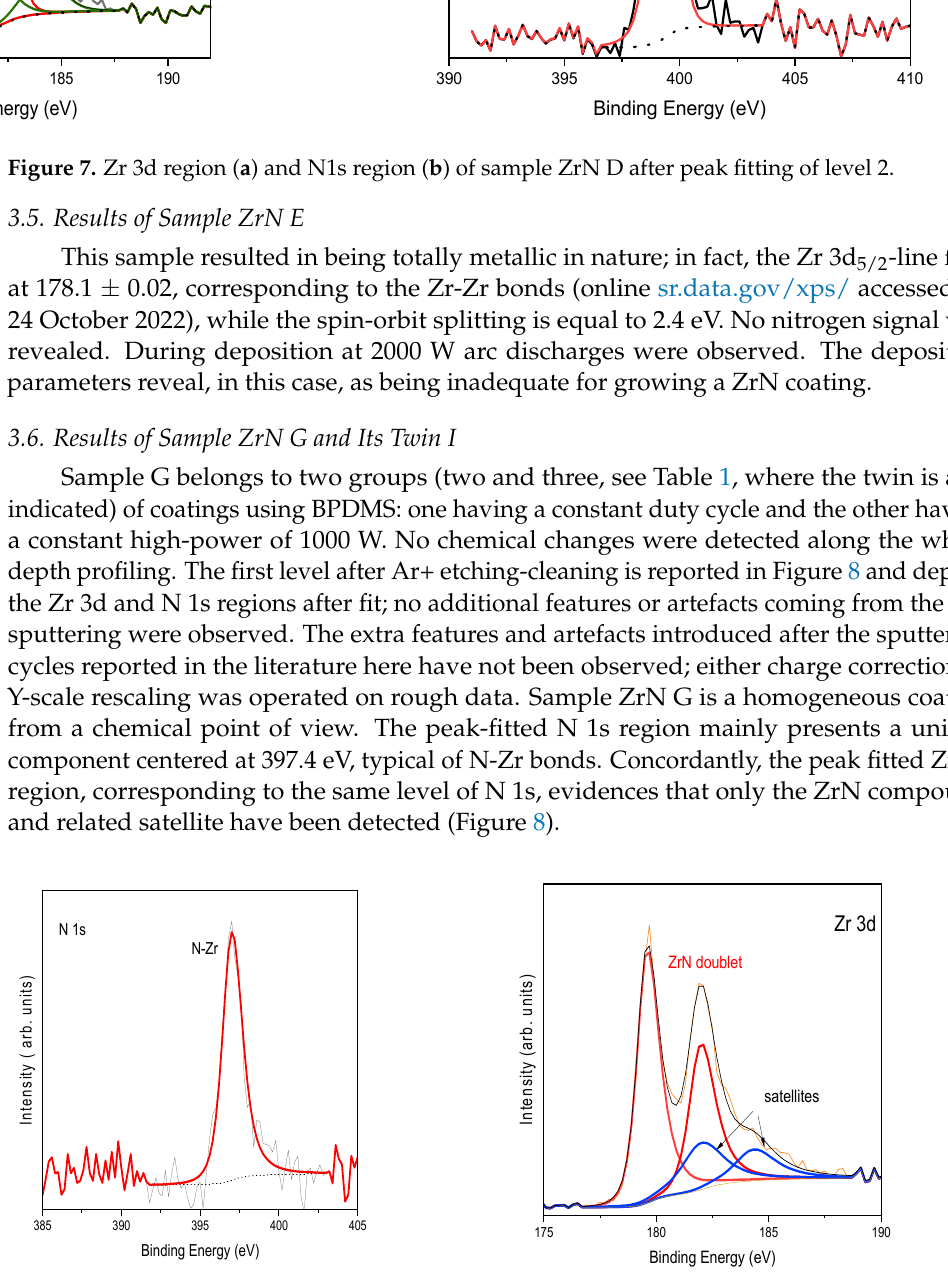
Figure 7. Zr 3d region figure 7 a ) and N1s region figure 7 b ) of sample ZrN D after peak fitting of level